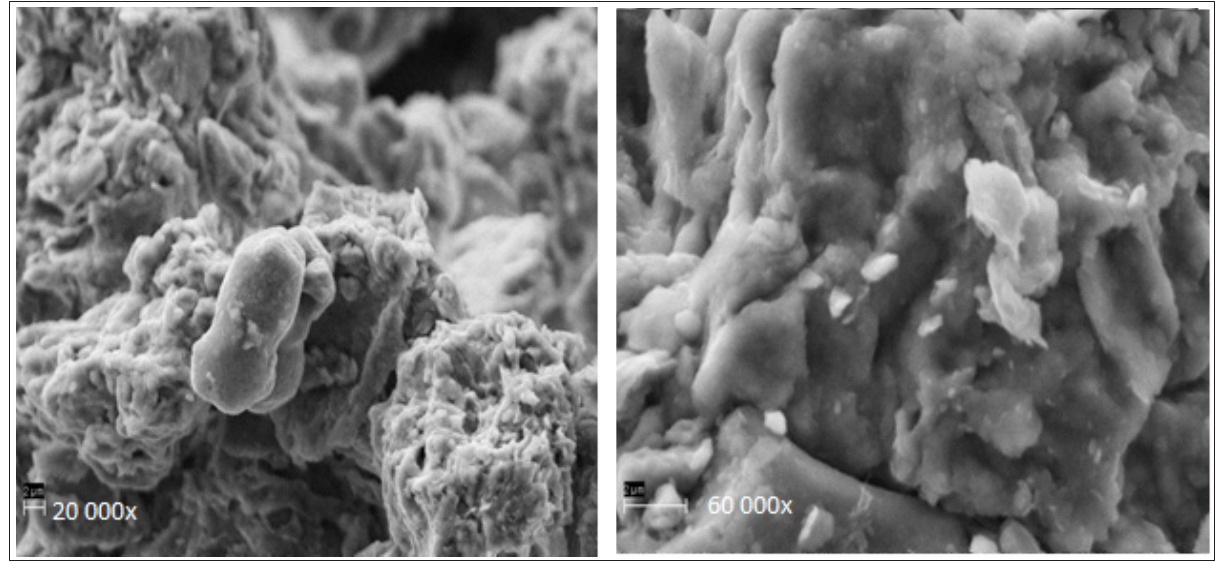
Figure 2: Scanning electron micrograph of the surface morphology of smectite-rich clay